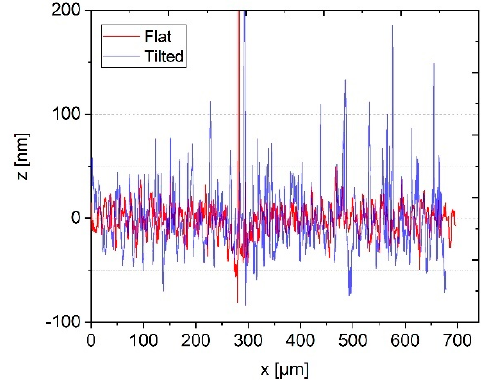
Figure 5. Measured roughness profiles of a well aligned optical flat (red curve) and an inclined optical flat (blue curve) for a low scanning speed of 20 µm/s.